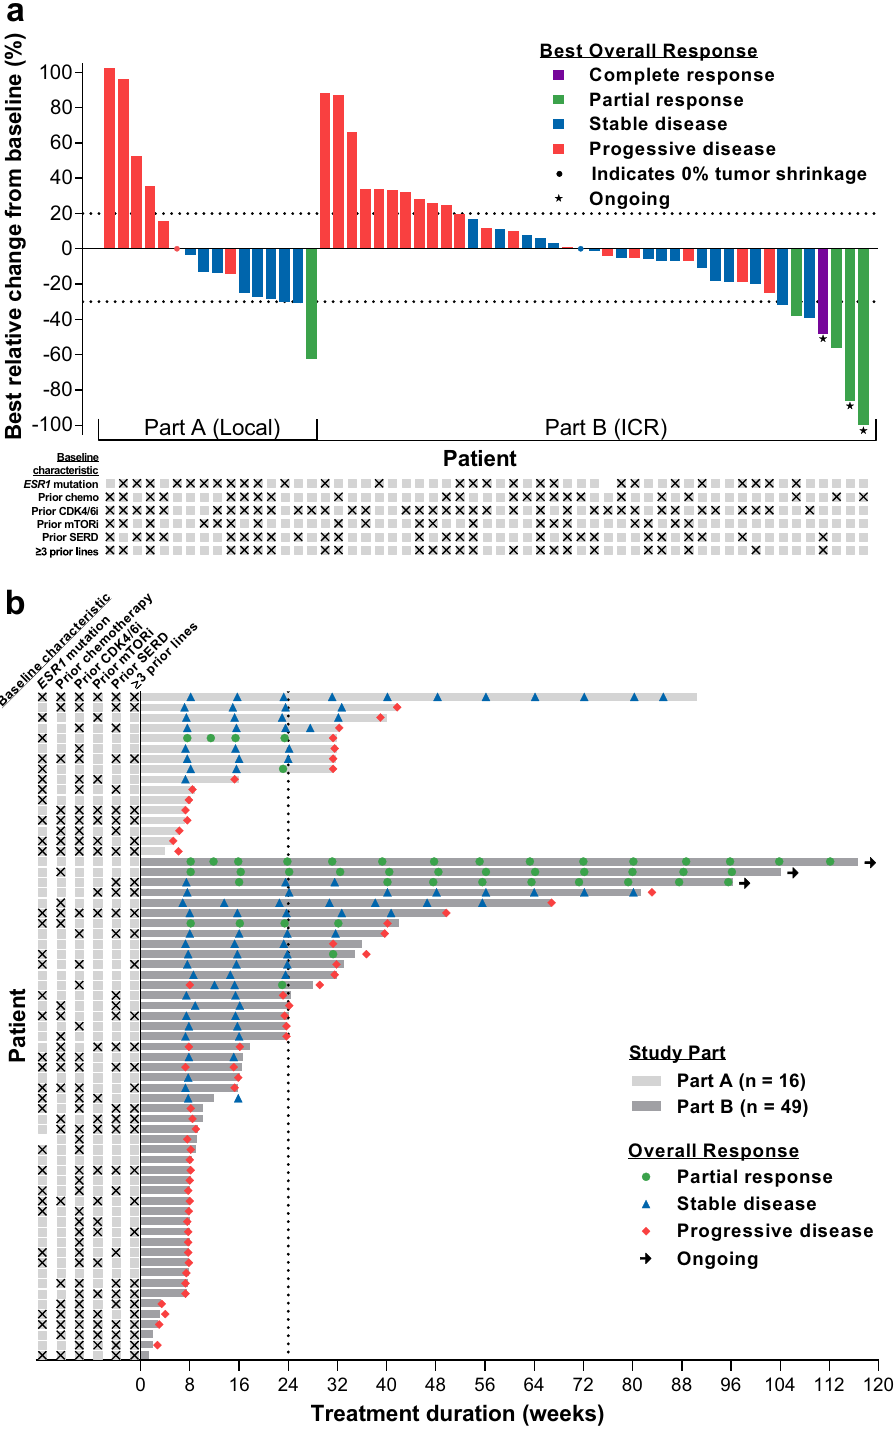
Fig. 3 Waterfall and swimmer plots. a Waterfall plot of best relative change from baseline in the sum of diameters of target lesions in the response- evaluable populations of Part A by local investigators/radiologists review ( n = 16) and Part B by independent central review ( n = 41; three patients were missing relative change data and two patients had a non-evaluable best overall response) and b Swimmer plot of duration of treatment in the safety populations of Part A ( n = 16) and Part B ( n = 49) with overall responses assessed by local investigators/radiologists review. CDK4/6i cyclin-dependent kinase 4/6 inhibitor, chemo chemotherapy, ICR independent central review, Local local investigators/radiologists review, mTORi mammalian target of rapamycin inhibitor, SERD selective estrogen receptor degrader. Checkboxes correspond to baseline